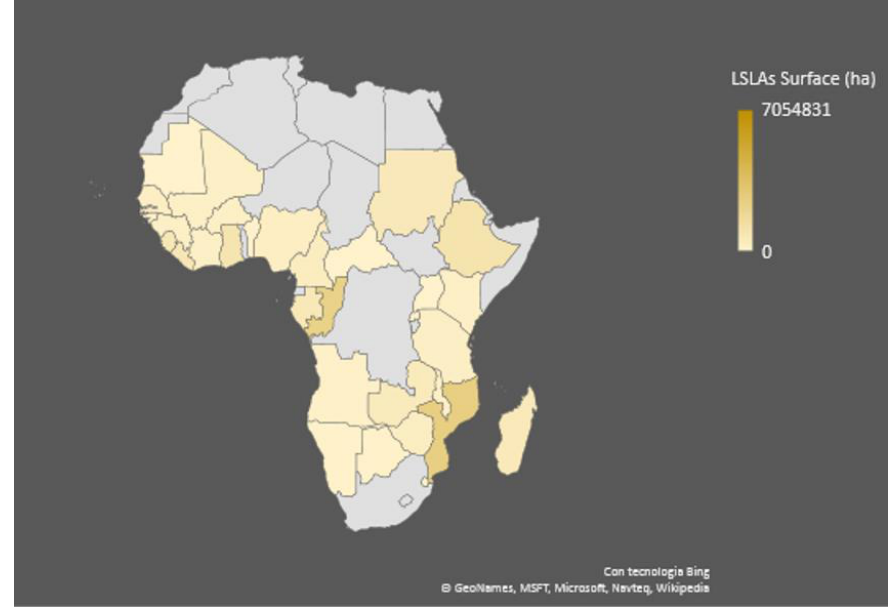
Figure 1. LSLA surfaces of the sample countries in ha.